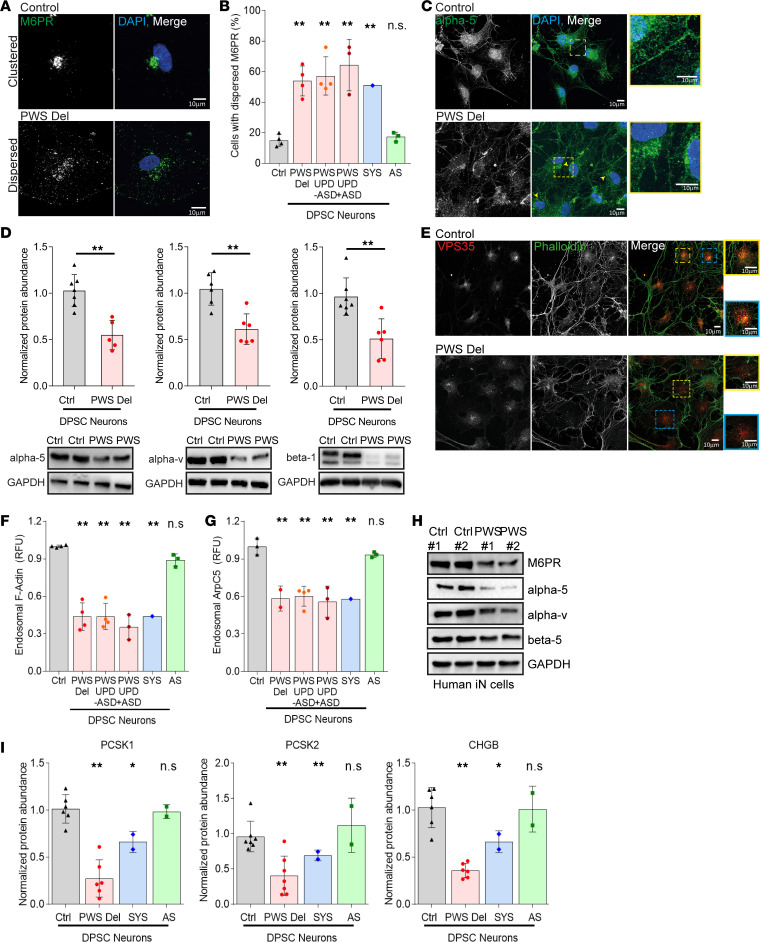
DPSC-derived neurons from PWS patients have impaired endosome-mediated protein trafficking and decreased SG protein abundance.(A) Representative images of immunofluorescence staining of M6PR in DPSC-derived neurons. Proper M6PR trafficking shows clustered juxtanuclear localization. (B) Proportion of cells with impaired M6PR trafficking is significantly increased in PWS and SYS DPSC-derived neurons. Each data point represents 1 individual, plotted as mean ± SD; more than 75 cells/data point, analyzed by 1-way ANOVA. (C) Representative images of immunofluorescence staining of integrin α5 in DPSC-derived neurons. Yellow arrows indicate increased intracellular (endosomal) pools. (D) Quantification of Western blot analysis showed reduced expression of integrin α5, αV, and β1 in PWS deletion DPSC-derived neurons. Each target protein is first normalized to GAPDH, then normalized to averaged control. Each data point represents 1 individual (n = 6), plotted as mean ± SD and analyzed by unpaired, 2-tailed t test. (E) Representative images of immunofluorescence staining of phalloidin on VPS35-marked endosomes in DPSC-derived neurons. (F) Fluorescence intensity of F-actin on VPS35-marked endosomes is significantly decreased in PWS and SYS DPSC-derived neurons. Each data point represents 1 individual, plotted as mean ± SD; more than 75 cells/data point, analyzed by 1-way ANOVA. (G) Fluorescence intensity of ArpC5 on VPS35-marked endosomes is significantly decreased in PWS and SYS DPSC-derived neurons. Each data point represents 1 individual, plotted as mean ± SD; more than 75 cells/data point, analyzed by 1-way ANOVA. (H) Western blot analysis of M6PR, α5, αV, and β5 between control and PWS iN. GAPDH served as loading control. (I) Quantification of Western blot analysis showed reduced expression of PCSK1, PCSK2, and CHGB in PWS deletion and SYS DPSC-derived neurons. Each target protein is first normalized to GAPDH, then normalized to averaged control. Each data point represents 1 individual, plotted as mean ± SD and analyzed by unpaired, 2-tailed t test. *P < 0.05 and **P < 0.01. Scale bars: 10 μm.